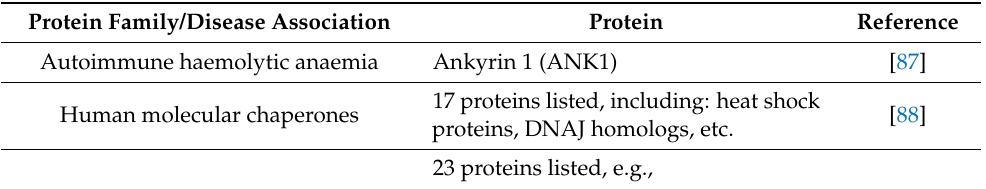
Table 1. Human proteins found with identical sequences to SARS-CoV-2 proteins based on protein families and disease